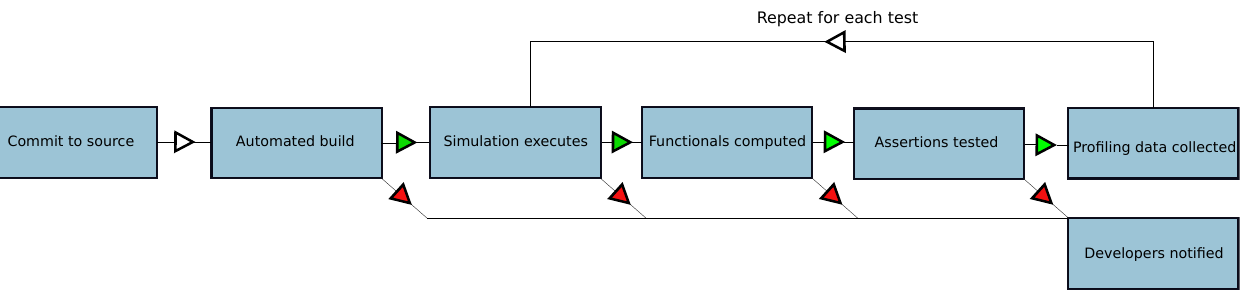
Fig. 1. The workflow for the continuous testing procedure. The test procedure is repeated for each test and the manner of any failure of that test is reported to the